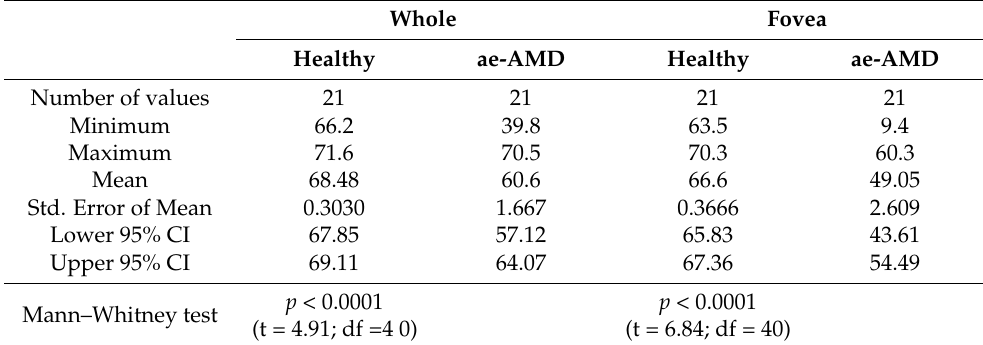
Table 2. Descriptive statistics for the whole and fovea area of choriocapillaris vascular density (%).